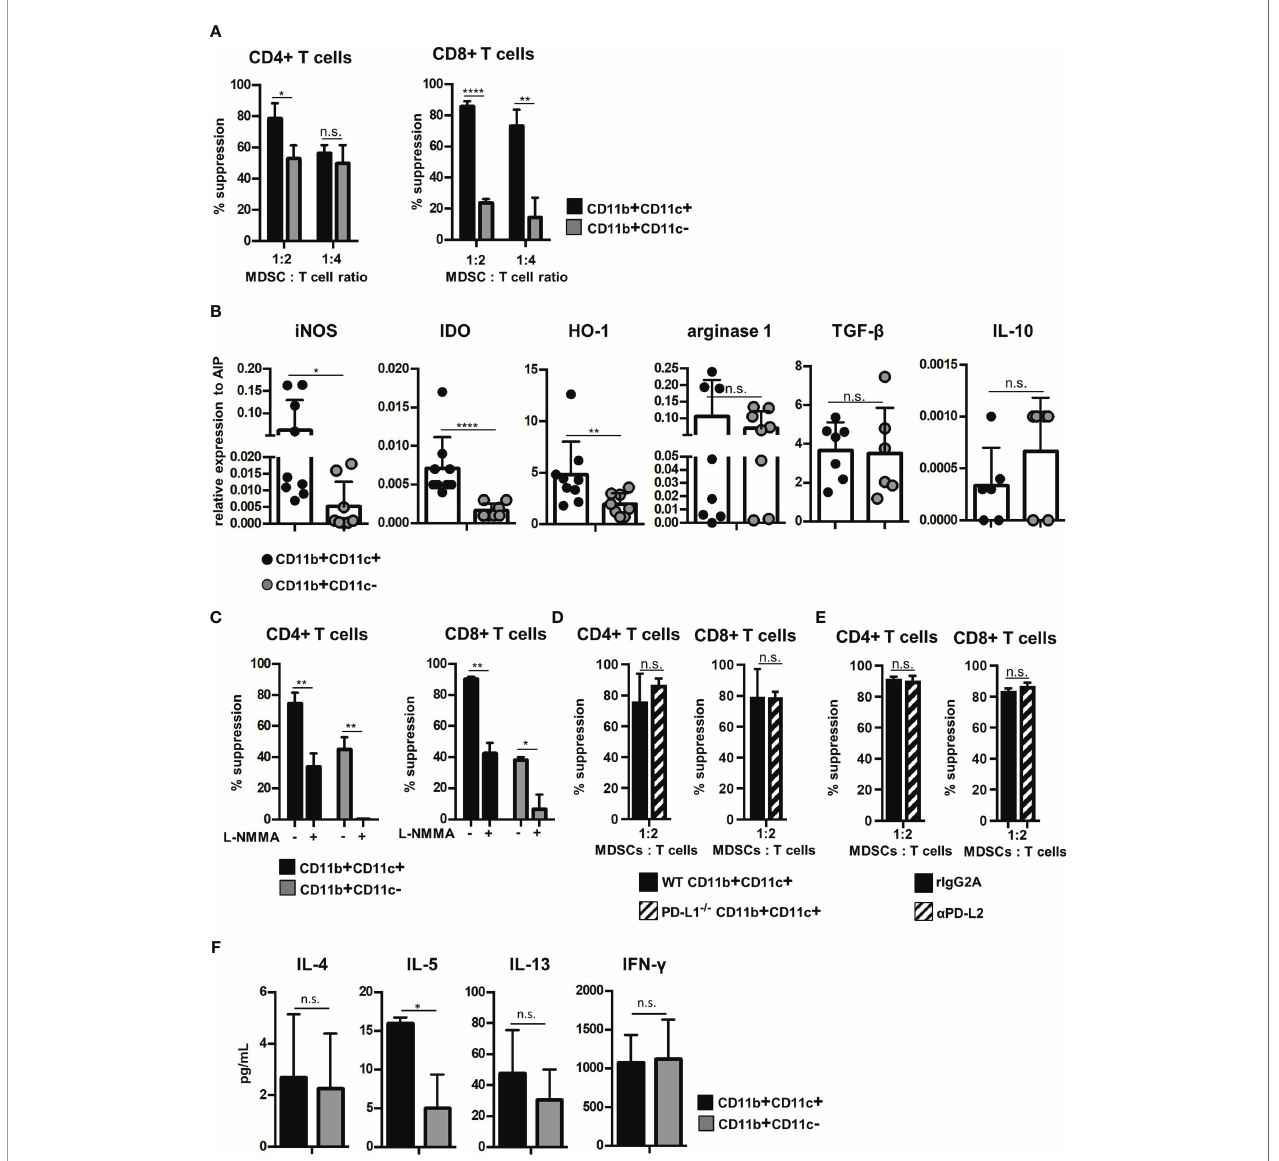
FIGURE 2 | CD11b+CD11c+ MDSCs exhibit increased immunosuppressive capacity than CD11b+CD11c − MDSCs and induce type 2 immunity in vitro . CD11b+CD11c+ and CD11b+CD11c − MDSCs were isolated from B6-derived (H-2 b , CD45.2+) in vitro -generated MDSCs. (A) CD11b+CD11c+ or CD11b+CD11c − MDSCs were cocultivated with B6.SJL-derived (H-2 b , CD45.1+) CFSE-labeled spleen cells stimulated by irradiated allogeneic DBA/2-derived (H-2 d , CD45.2+) spleen cells. After 4 days, CD45.1+ T cells were stained for CD3, CD4, and CD8 and suppression of CD4+ and CD8+ T-cell proliferation was calculated. (B) CD11b+CD11c+ and CD11b+CD11c − MDSC subpopulations were analyzed for relative expression of immunosuppressive molecules by qRT-PCRs. (C) CD11b+CD11c+ or CD11b+CD11c − MDSCs were cocultivated with B6.SJL-derived CFSE-labeled spleen cells stimulated by irradiated allogeneic DBA/2-derived spleen cells in the absence or presence of iNOS inhibitor L-NMMA (500 µM). After 4 days, suppression of CD4+ and CD8+ T-cell proliferation was determined. (D) B6-derived wildtype (WT) and PD-L1 − / − CD11b+CD11c+ or CD11b+CD11c − MDSCs were cocultured with CFSE-labeled B6.SJL-derived spleen cells stimulated with irradiated allogeneic DBA/2 spleen cells. (E) To block PD-L2, antagonistic PD-L2 antibodies or recombinant isotype control were added to MLRs, in which CFSE-labeled B6.SJL-derived spleen cells were stimulated with irradiated allogeneic DBA/2 spleen cells in the presence of CD11b+CD11c+ MDSCs. (F) CD11b+CD11c+ or CD11b+CD11c − MDSCs were cocultivated with B6.SJL-derived CFSE-labeled spleen cells stimulated by irradiated allogeneic DBA/2-derived spleen cells. After 4 days, secretion of cytokines associated with type 2 T-cell immunity (IL-4, IL-5, and IL-13) or type 1 T-cell immunity (IFN- g ) were determined in the supernatants. (A) Data represent the mean value ± SD of triplicates of one representative experiment out offour experiments performed. (B) Data represent the mean value ± SD of six to nine samples. (C) Data represent the mean value ± SD of triplicates of one representative experiment out of three experiments performed. (D) Data represent the mean value ± SD of n = 3 PD-L1 − / − and WT mice. (E) One experiment out of two experiments performed. Values present the mean value ± SD of triplicates. (F) Data represent the mean value ± SD of n = 3 experiments. (A, C – F) Student ’ s t -test. (B) Mann-Whitney U test. * p ≤ 0.05; ** p ≤ 0.01; **** p ≤ 0.0001. n.s., not signi fi